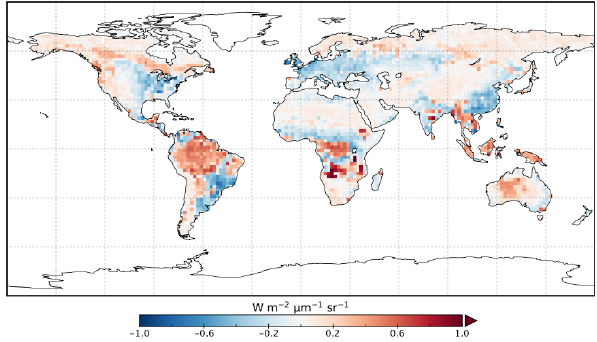
Figure 2. Annual mean residual between model SIF prior and ob- served SIF for 2015.